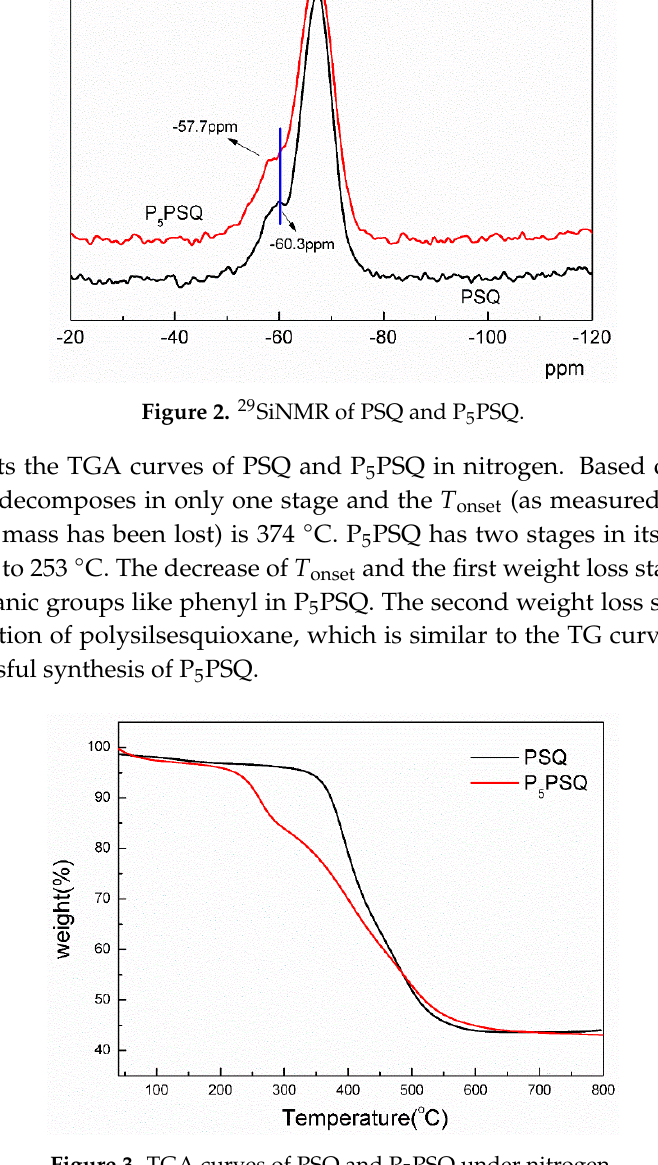
Figure 1. FT-IR spectra of PSQ and P 5 PSQ.